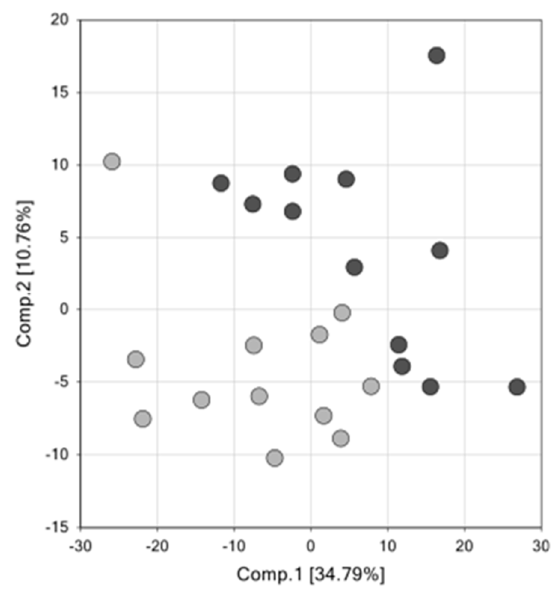
Figure 1. Principal components analysis demonstrates that the global metabolome from placenta samples in spontaneous preterm birth (SPTB) is overall distinguishable from the metabolome of term placenta samples. SPTB placentas: dark gray circles ( n = 12); Term placenta: light gray circles ( n = 12). For the analysis shown in Figure 1, the X -axis (Comp1) represents 34.79% of the variability between samples and the Y -axis (Comp 2) represents 10.79% of the variability between samples.